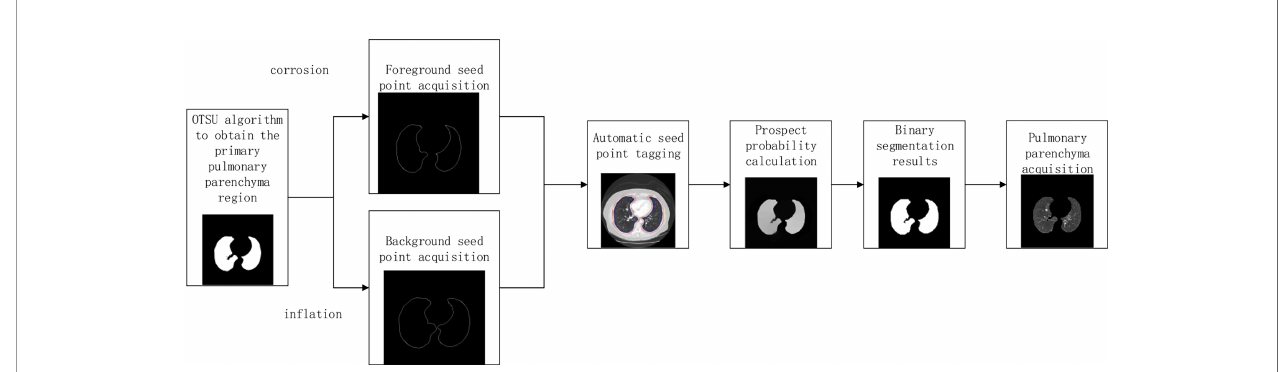
FIGURE 3 | Flowchart of lung parenchyma segmentation based on automatic random walk algorithm.